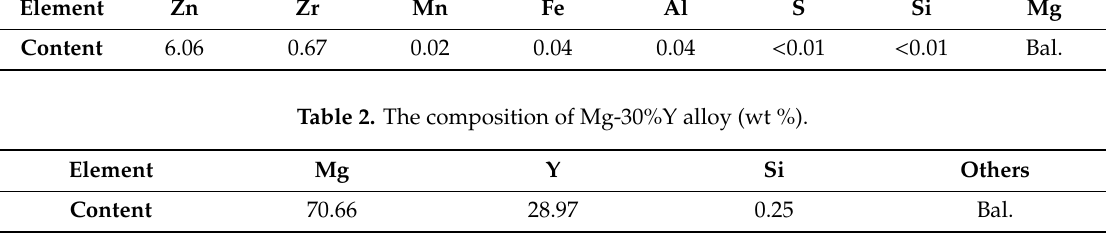
Bal. Table 2. The composition of Mg-30%Y alloy (wt%).